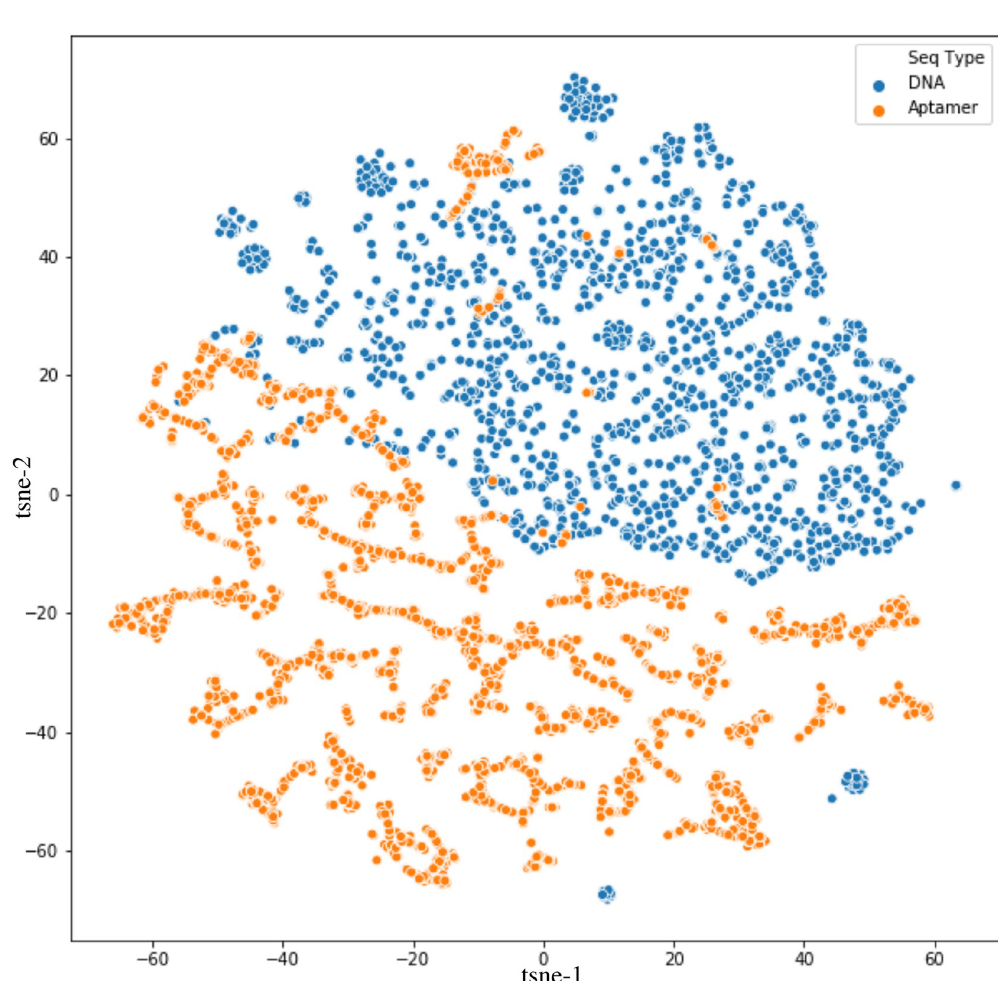
Fig 3. t-SNE of the Dataframe colored by sequence type. Blue dots depicts genomic DNA sequences, while orange dots depicts DNA aptamer sequences.